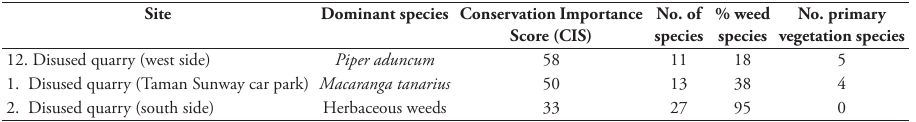
Table 10. Comparison of the species richness and conservation value amongst the three quarry sites. Site